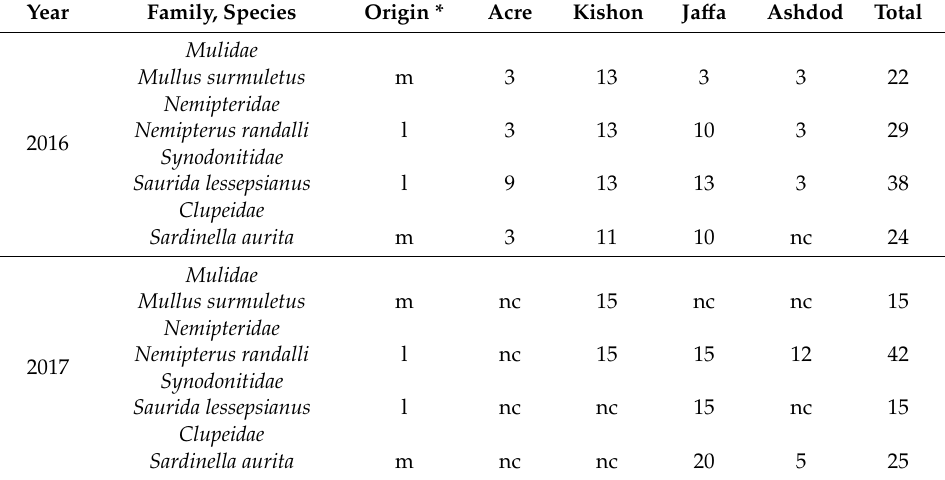
Figure 1. Geographical distribution of the sampling locations described in this study: ( A ) sampling area is in the most eastern basin of the Mediterranean Sea; and ( B ) fish were sampled from four fishing ports along the Israeli coast—two in the north (Acre and Kishon) and two in the south (Jaffa and Ashdod). Template map source: Google Earth. Table 1. Wild fish organisms sampled and analyzed in this study. Total number of specimens tested and number of wild fish sampled from each sampling site in 2016 and 2017.